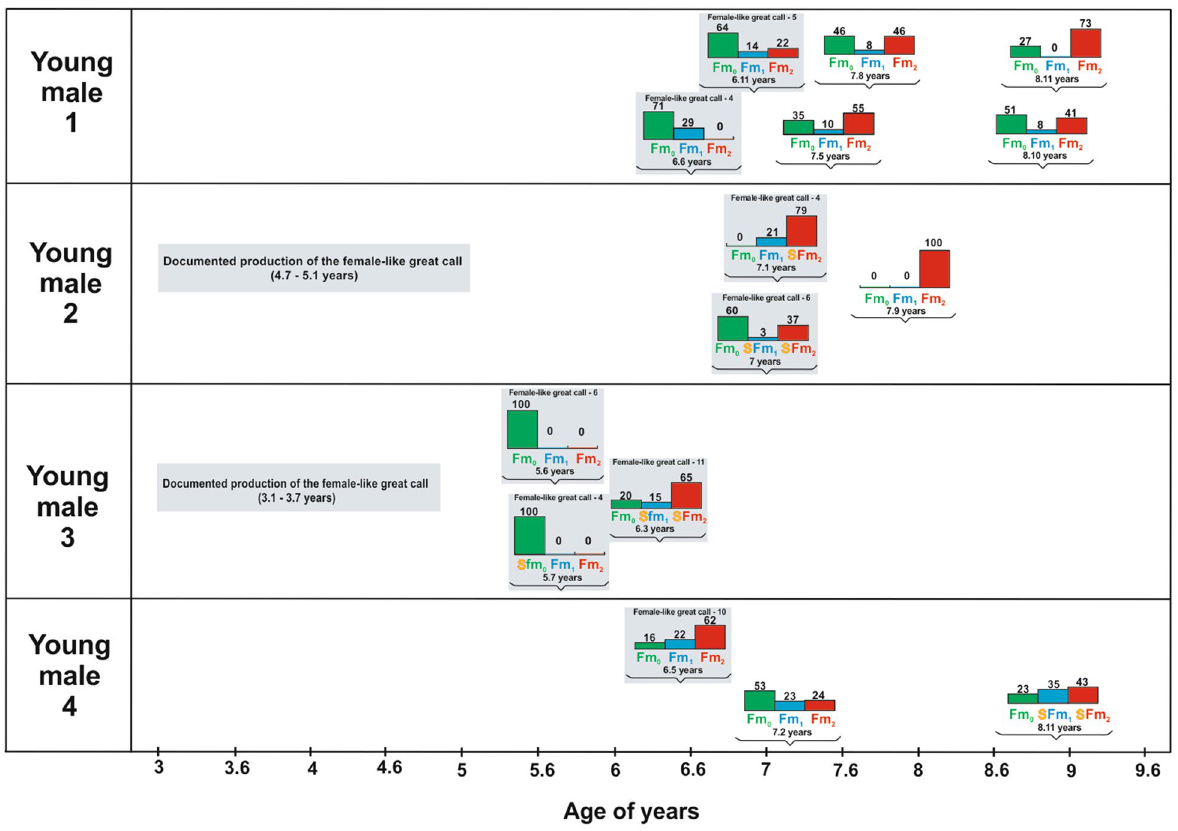
Figure 4. Barplots showing three different forms of multi-modulation phrases according to the number of frequency modulations (Fm 0-2 ), with or without the occurrence of staccato notes (S) during male vocal pattern development. Barplots delimited by a rectangle (purple background) indicate males that continued producing female-like great calls with their mothers during male call